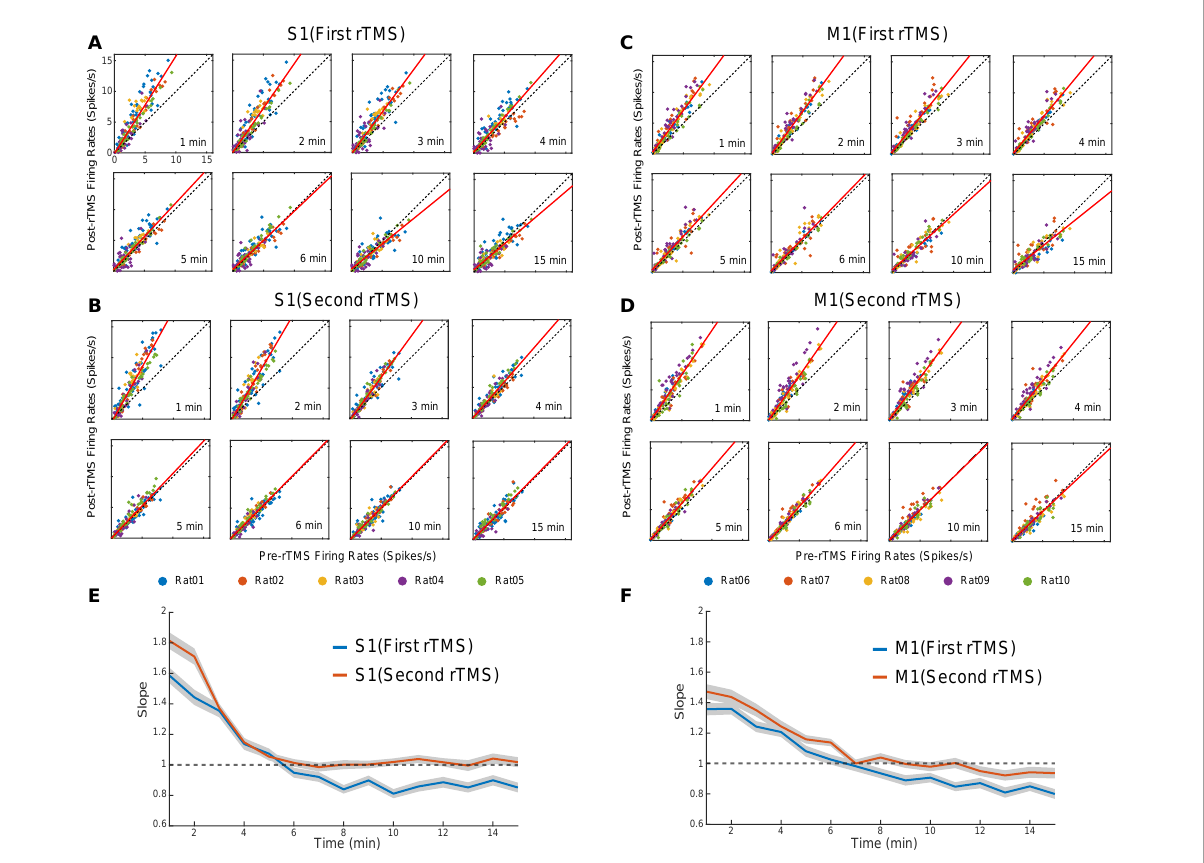
FIGURE12 Scatter plots of pre-rTMS vs. post-rTMS firing rates (bin size: 1 min) of neurons at different time points (1, 2, 3, 4, 5, 6, 10, 15 min) after each course of rTMS. Firing rates of S1 neurons are compared before and after the first (A) and second (B) course of rTMS ( n = 163). Firing rates of M1 neurons are compared before and after the first (C) and second (D) course of rTMS ( n = 149). Linear regression (solid line) is superimposed on the scatter plots. (E,F) The slope of the linear fits at each time points after rTMS for both S1 and M1 neurons. Shaded areas: